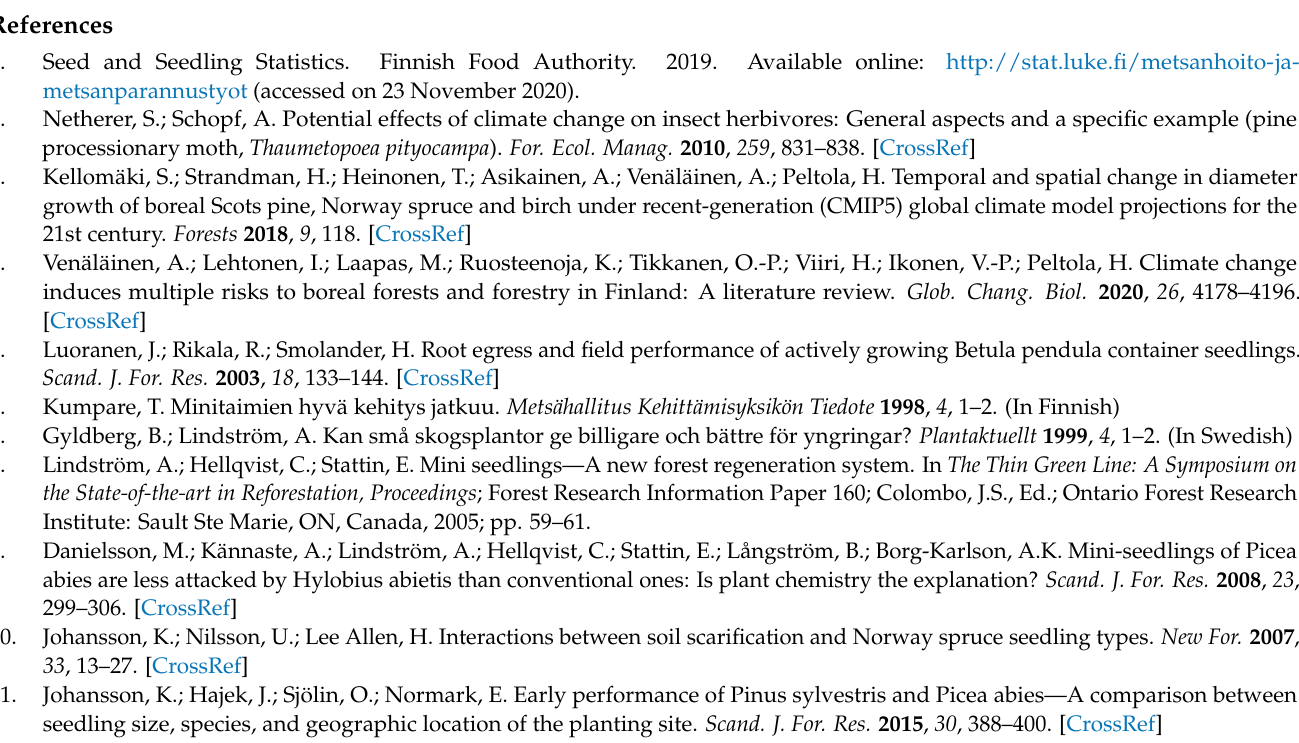
Figure A1. Soil temperatures at different planting depths during the growing seasons in ( a ) 2019 and ( b ) 2020 in the Scots pine